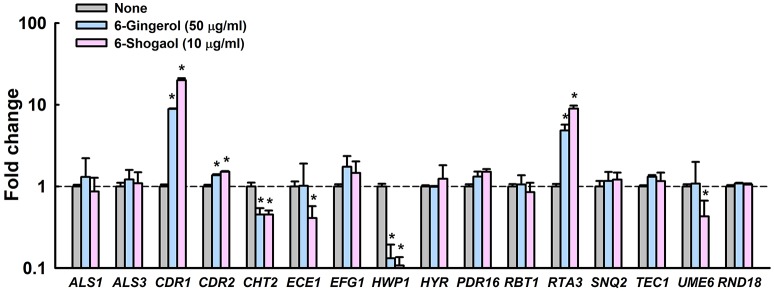
Transcriptional profiles of C. albicans cells treated with or without 6-gingerol or 6-shogaol. C. albicans was cultivated with or without 6-gingerol at 50 μg/ml or 6-shogaol at 10 μg/ml for 4 h with shaking at 250 rpm. Transcriptional profiles were obtained by qRT-PCR. Fold changes represent changes in the transcriptions of treated vs. untreated C. albicans. The experiment was performed in duplicate (six qRT-PCR reactions were performed per gene). *P < 0.05 vs. non-treated controls (None).